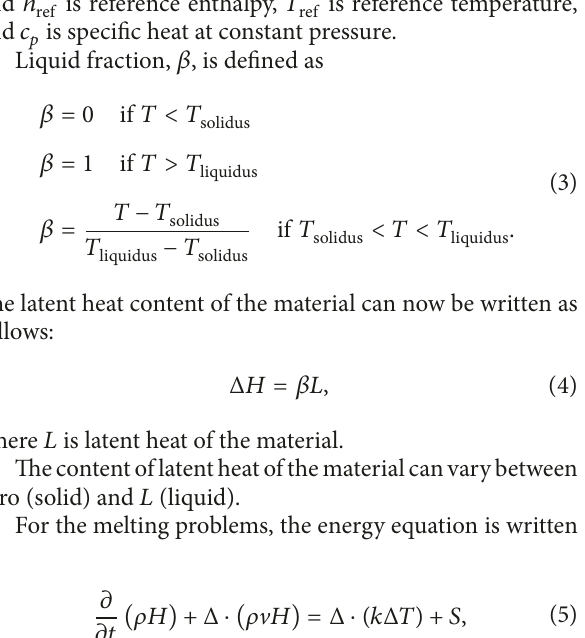
Figure 3: Temperature distribution of 𝑇 1 with grid size variation. SIMPLE scheme was used as the method for a solution, while PRESTO scheme was adopted for the pressure correction equation. First-order upwind scheme was used for solving the momentum and energy equations. Under relaxation